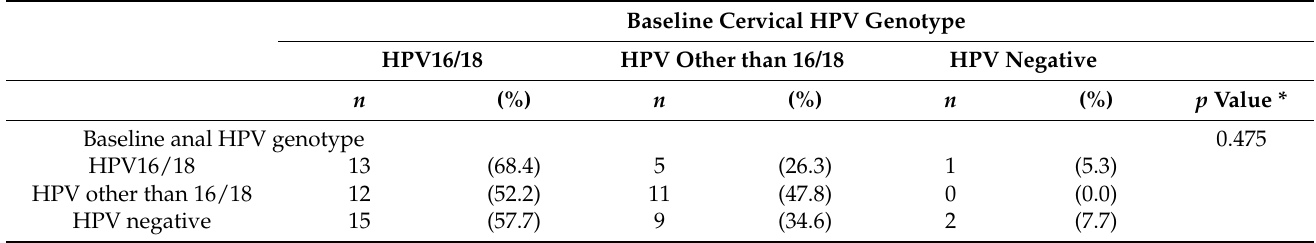
Table 2. Correlation of human papillomavirus (HPV) types between baseline cervical and baseline anal samples. Values are presented as absolute numbers and